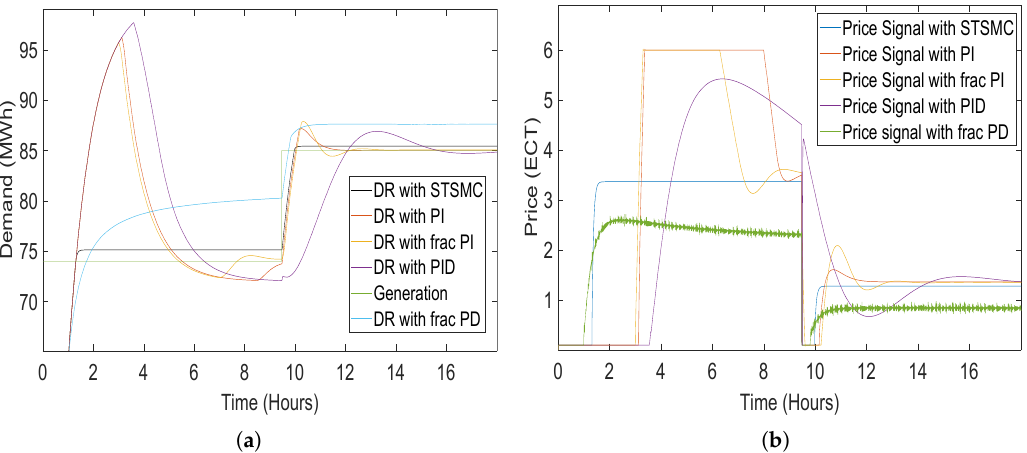
Figure 10. Demand and price response of the proposed model to step signal for classical and fractional order controllers: ( a ) demand response; ( b ) price